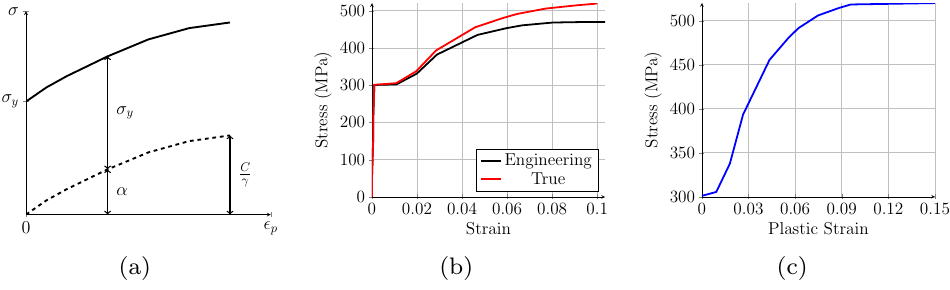
Figure 2. ( a ) Chaboche model with one kinematic model. ( b ) Experimental engineering and true stress–strain behavior of the material. ( c ) True stress vs. true plastic strain data for initial direct kinematic hardening model